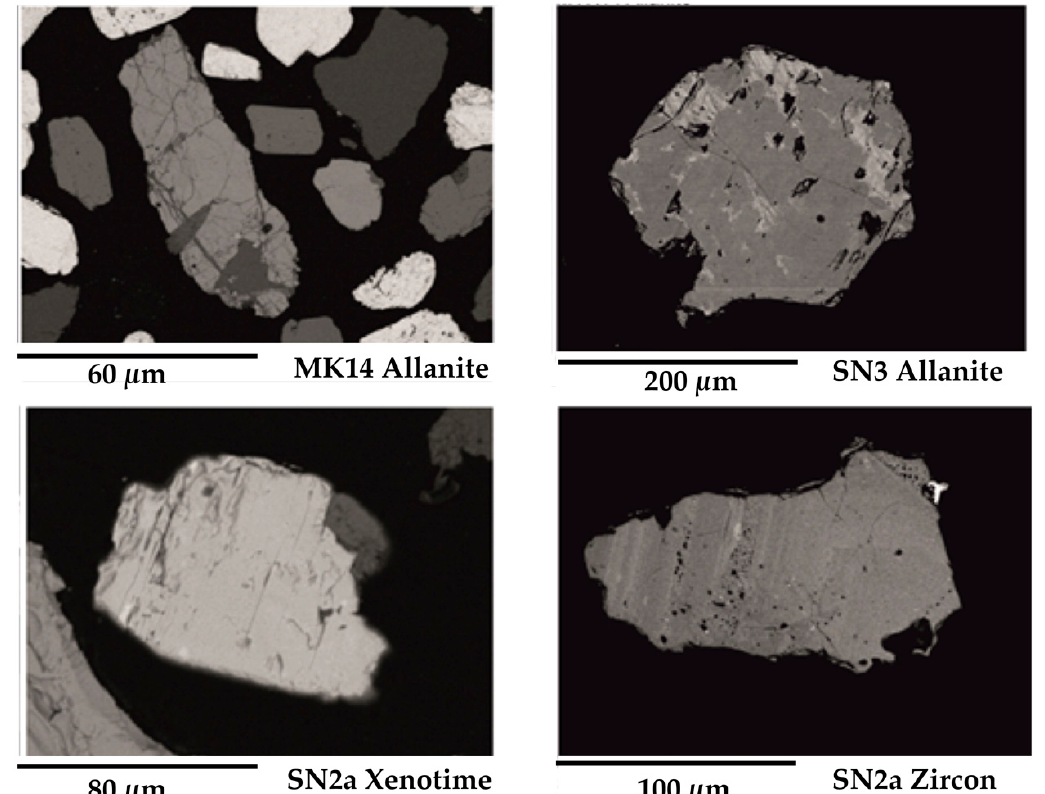
Figure 10. Back-scattered electron images of selected heavy mineral grains separated from coastal sands from the Atticicycladic zone